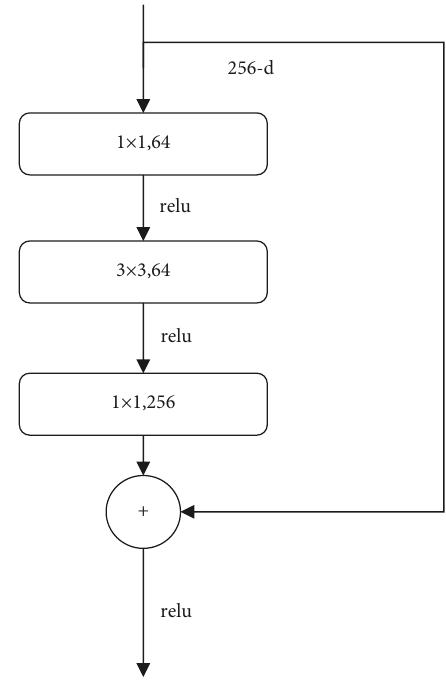
Figure 2: ResNet50 residual block